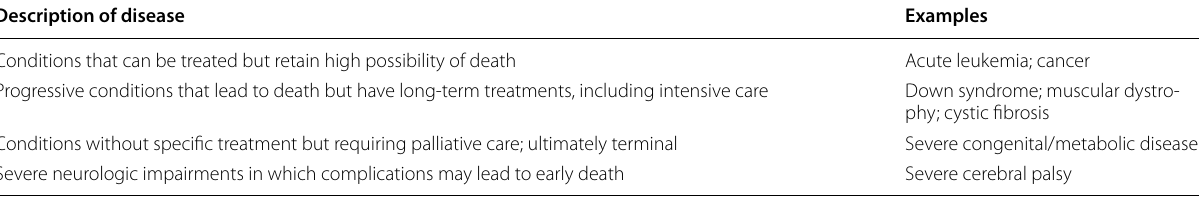
Table 1 Royal College of Pediatrics and Child Care’s classification of life-threatening diseases (Bogetz et al., 2014; Mellor and Hain,